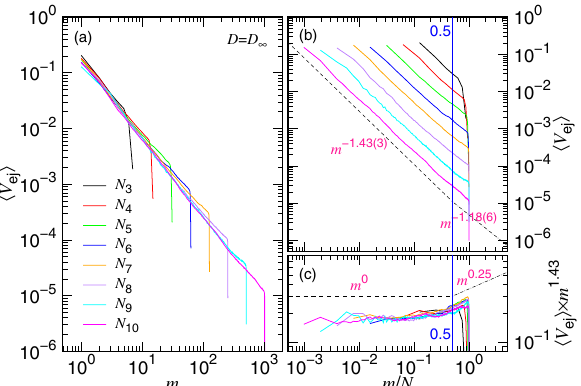
D for various chain lengths. = ∞